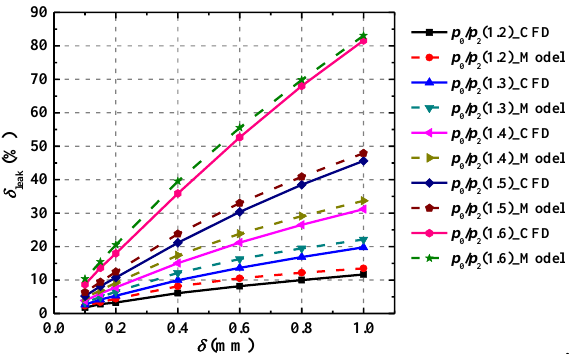
Figure 24. Variation of the relative leakage flow rate with the gap width.